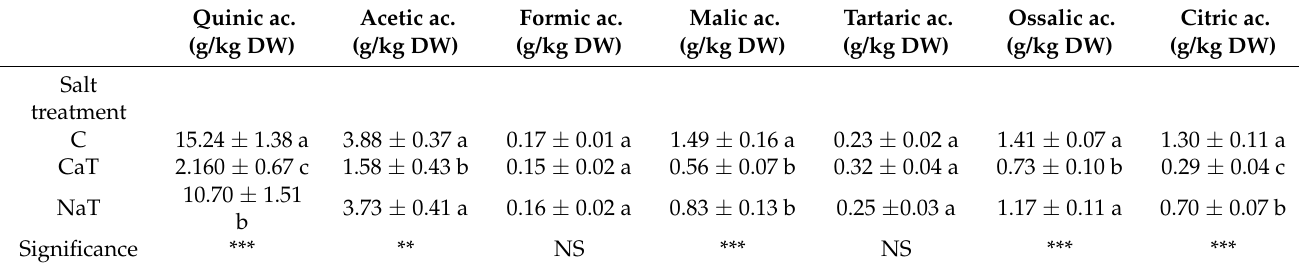
Table 6. Effects of salt treatment in the nutrient solution on main organic acids (quinic, acetic, formic, malic, tartaric, ossalic and citric acids) leaf content in C. citrinus plants. Mean values and standard errors are shown. Different letters correspond to significantly different values ( p <